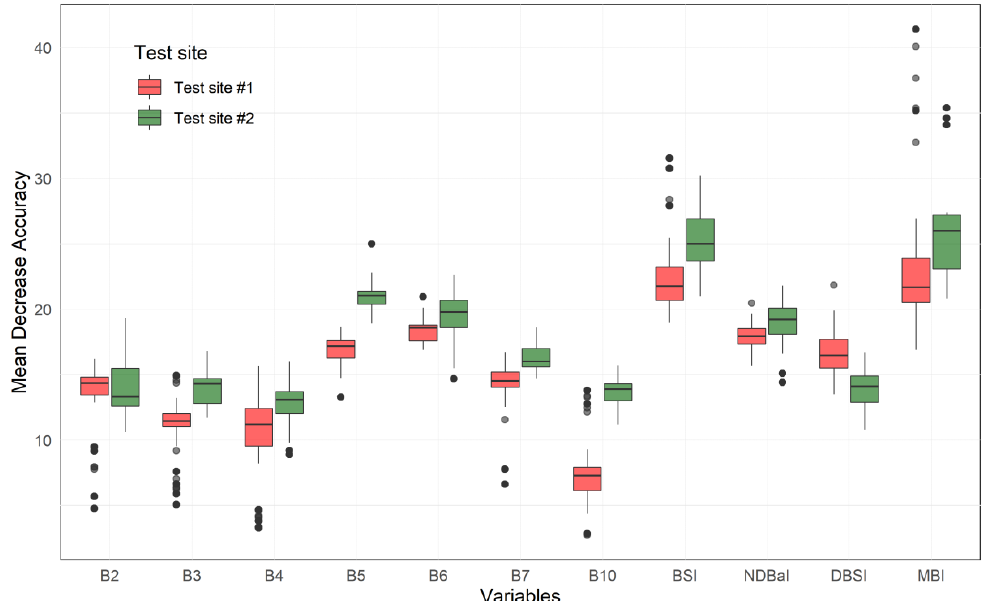
Figure 8. A boxplot shows mean decrease accuracy (MDA) by different Landsat 8 bands and four bare soil indices in random forest classification on the two test sites. Note: Values greater than 50% of MBI are not shown on the plot for better visualiza- tion.